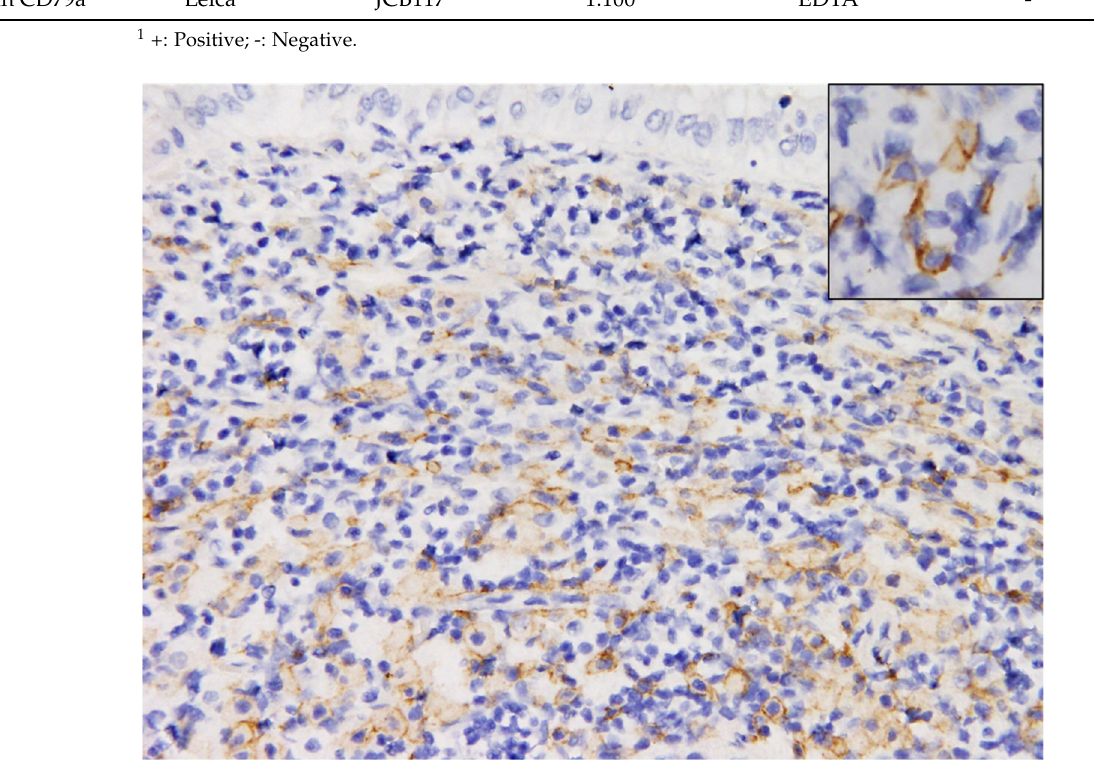
Figure 7. Gastric mast cell tumor (MCT), African dormouse, stomach, Toluidine blue stain. The ne- oplastic cells show strong metachromasia (400×). Both of MMCs and connective tissue mast cells